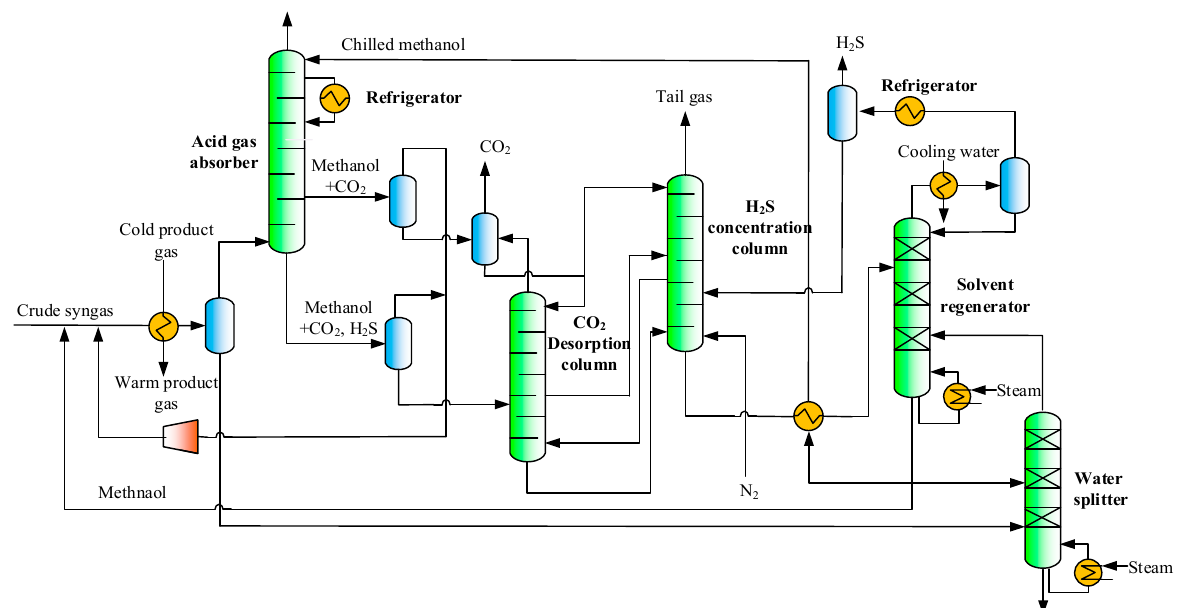
Figure 3. Simplified simulation flowsheet of the Rectisol technology.